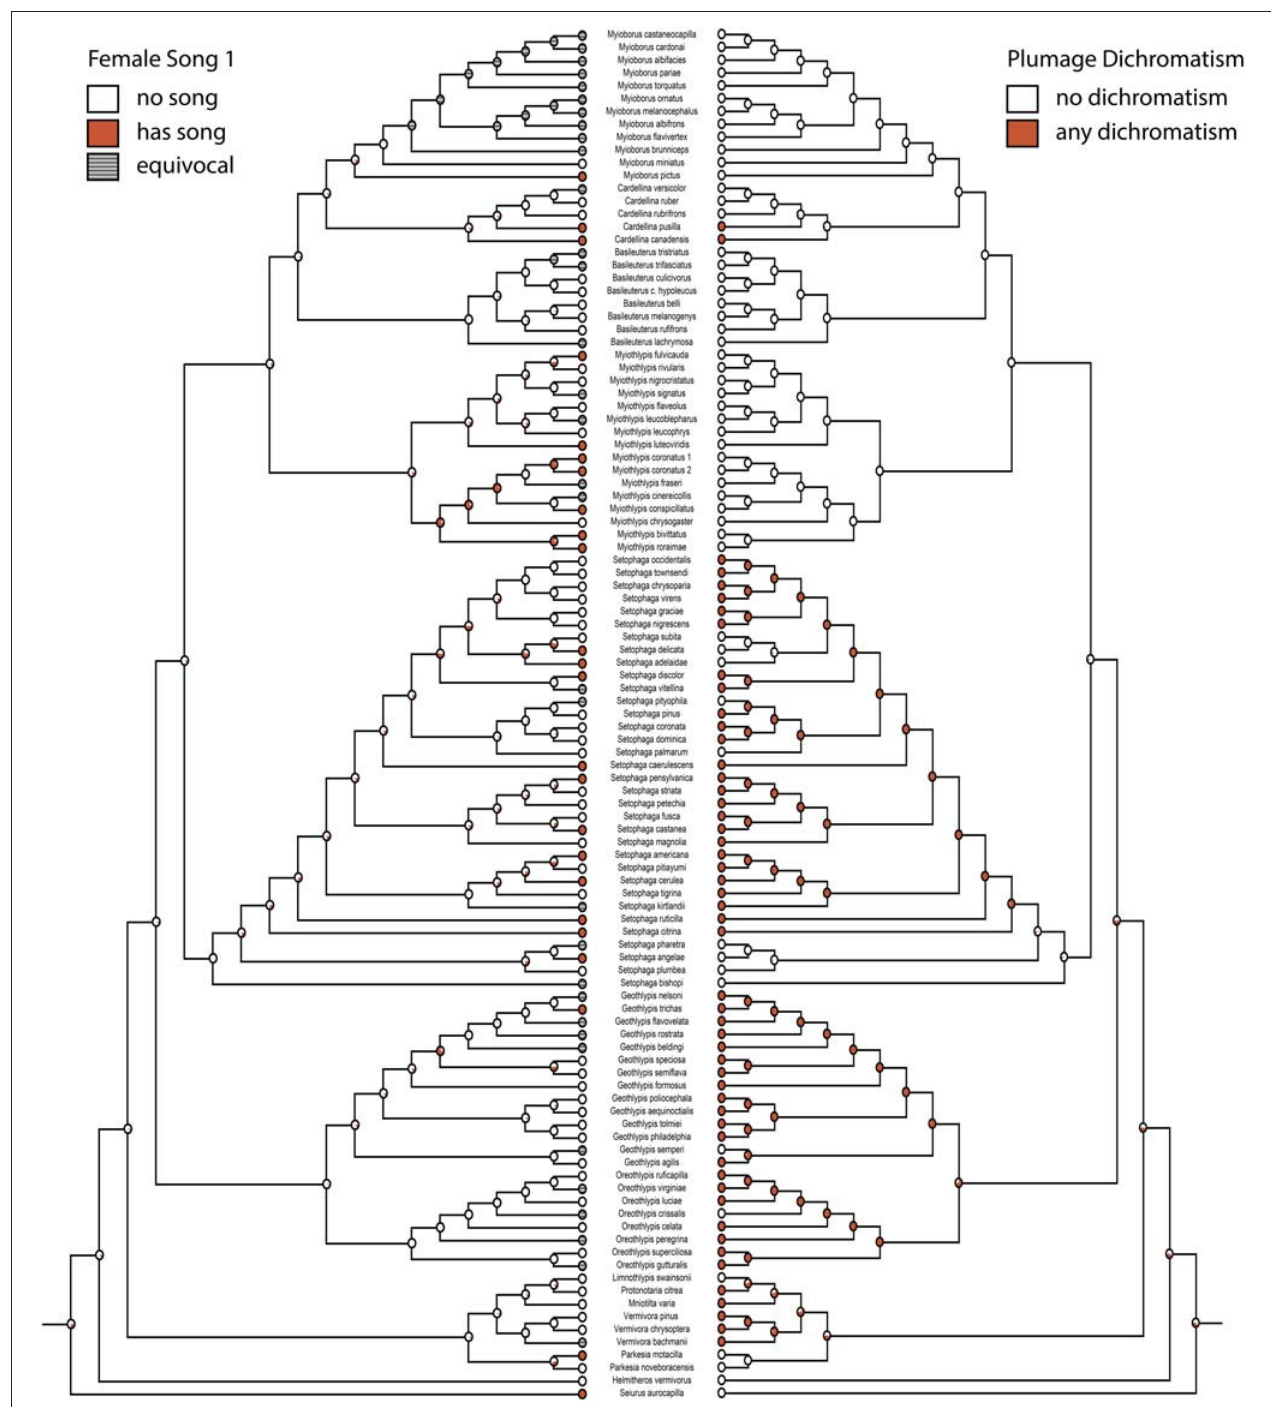
FIGURE 1 | Ancestral state reconstruction with female song 1 (mk2, log likelihood: − 45.95) on the left mirrored with any plumage dichromatism (mk1, log likelihood: − 56.91) on the right. Red circles have female song or are dichromatic and white circles do not, gray circles are equivocal. Pie charts indicate proportional